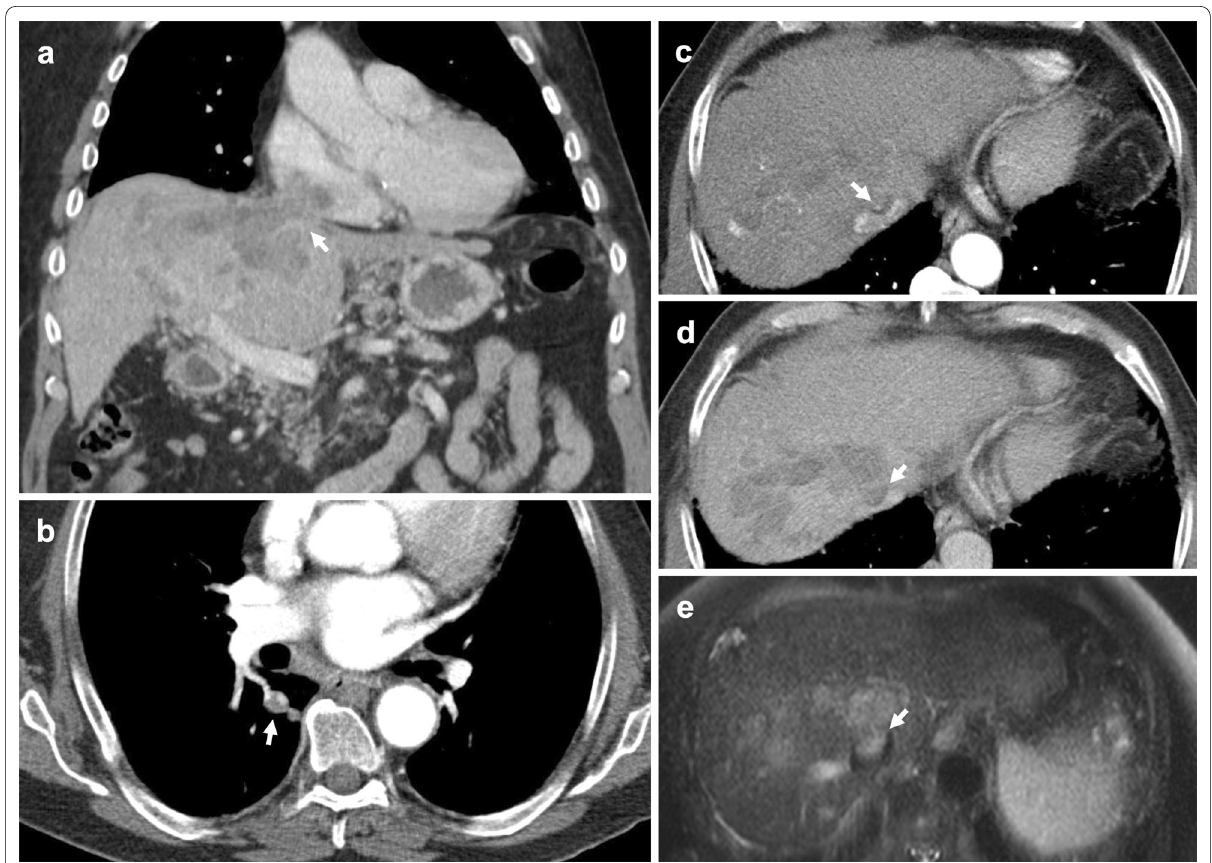
Fig. 17 Hepatocellular carcinoma with IVC tumour thrombus, direct invasion of the right atrium and embolic tumour thrombus. a Contrast-enhanced coronal CT depicts direct invasion of the HCC (arrow) into the right atrium. b Axial CT chest shows subsegmental right pulmonary artery dilatation with internal filling defect (arrow), likely due to embolic tumour thrombus. c Axial CT shows multifocal arterial enhancement in the liver, predominantly in segment 7 and 8. The IVC tumour thrombus also demonstrates arterial enhancement (arrow), d is visualised as a partial filling defect (arrow) in portal venous phase, and e shows intermediate T2 signal (arrow) with extension into the hepatic IVC via the middle hepatic